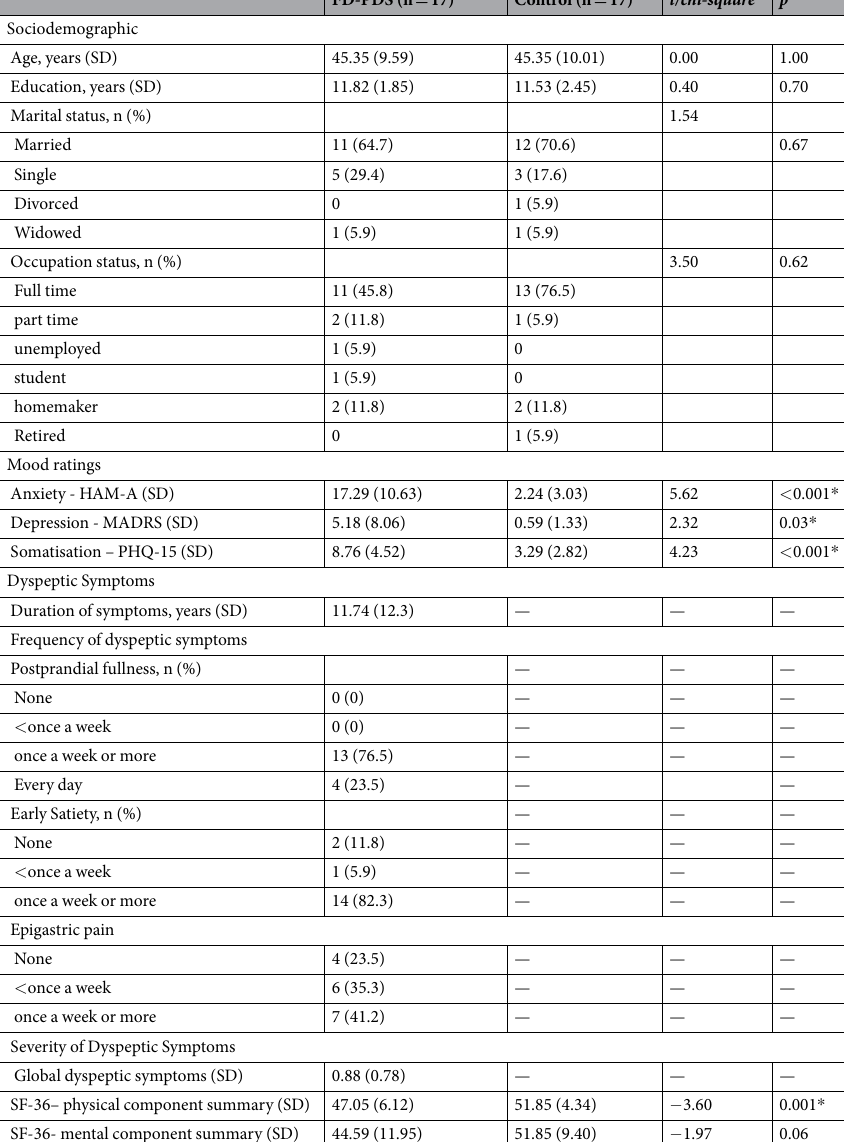
Table 2. Demographic and Clinical Information in FD-PDS and Controls. * p <